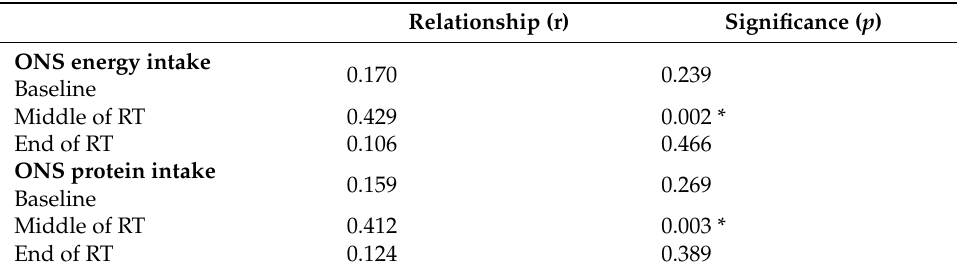
Table 7. Correlation between total NIS score and ONS energy and protein intake ( n =